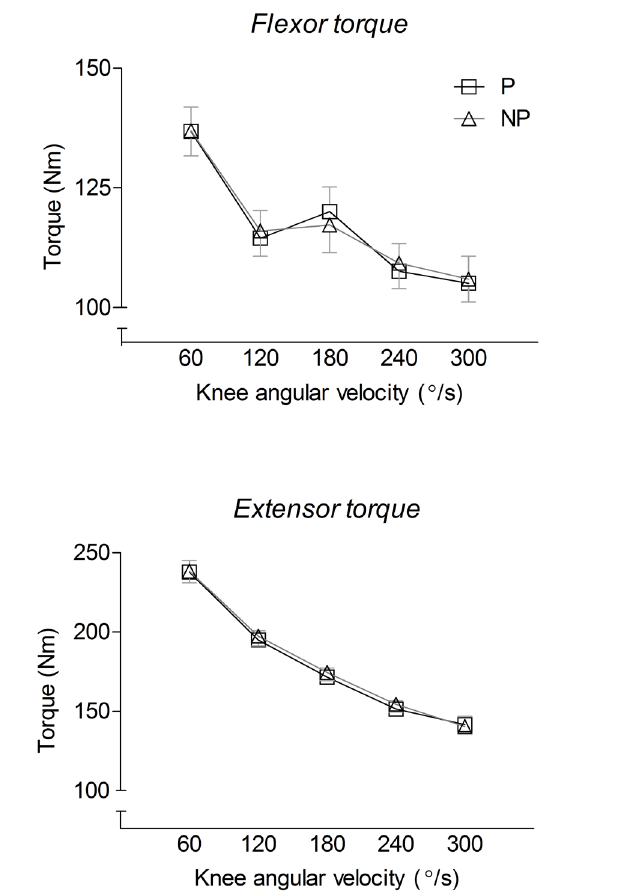
Figure 2. Torque-velocity relationship for knee flexors (top) and extensors (bottom) during isokinetic trials.